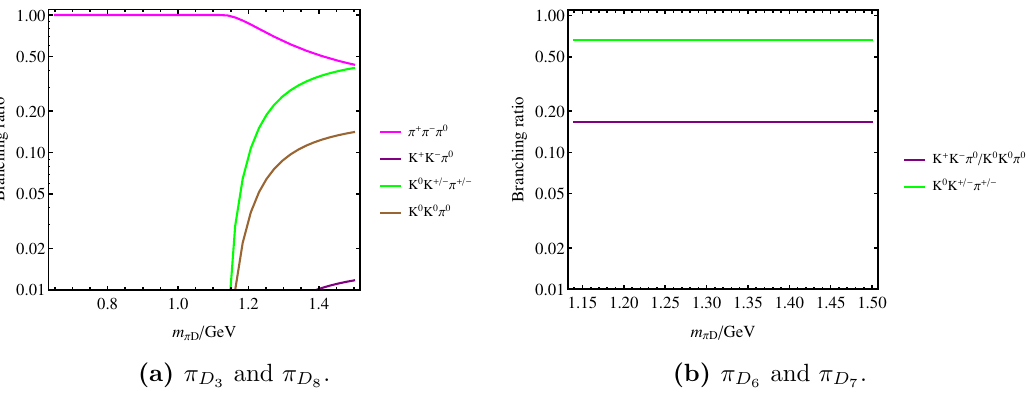
(a) (cid:25) D 3 and (cid:25) D 8 . Figure 13. Branching ratios for (left) (cid:25) D 3 and (cid:25) D 8 , and (right) (cid:25) D 6 and (cid:25) D 7 , within the \23" sce- nario.